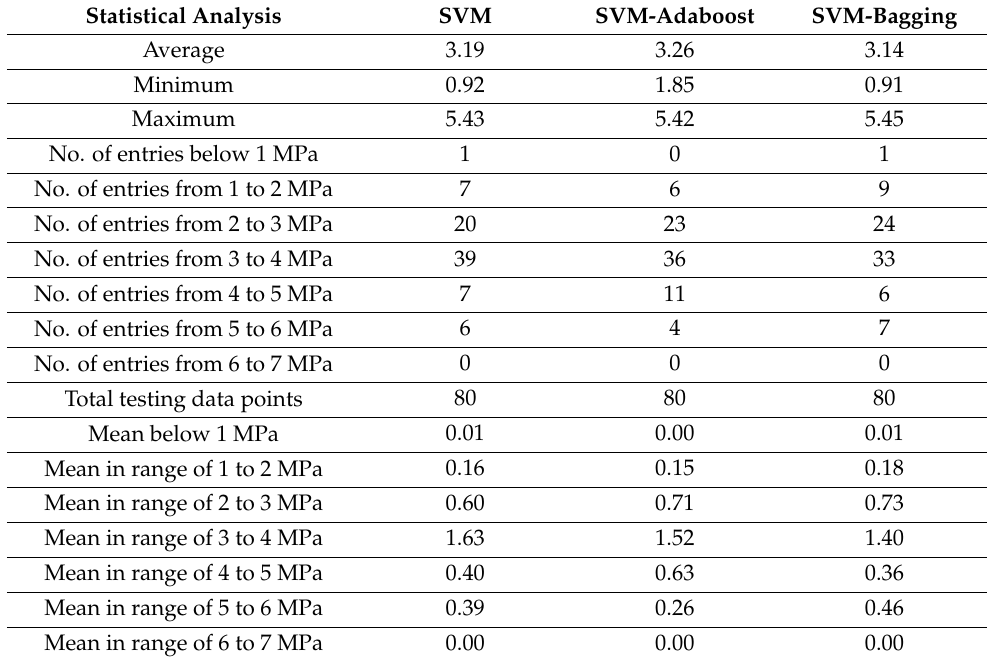
Table 14. Statistical analysis of tensile strength SVM model.